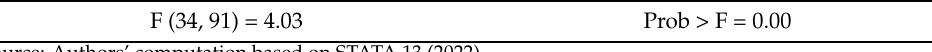
Table 2. Results for time effects.